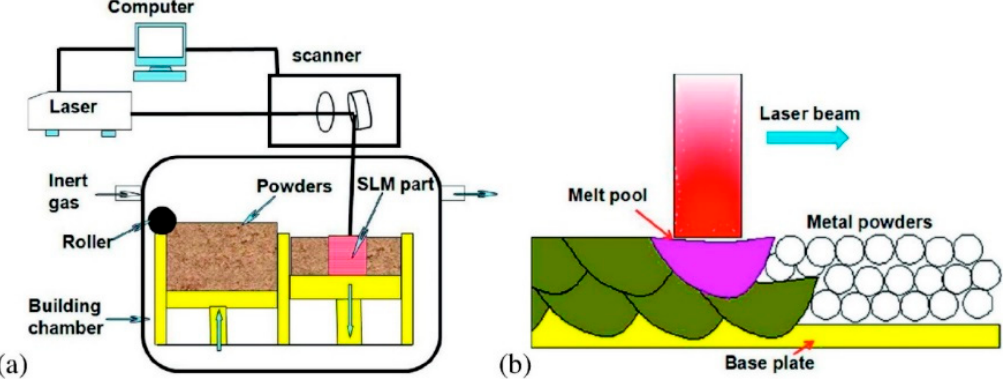
Figure 20. ( a ) Graphic representation of the SLM equipment; ( b ) the melt pool production method (adapted with permission from reference [57]).